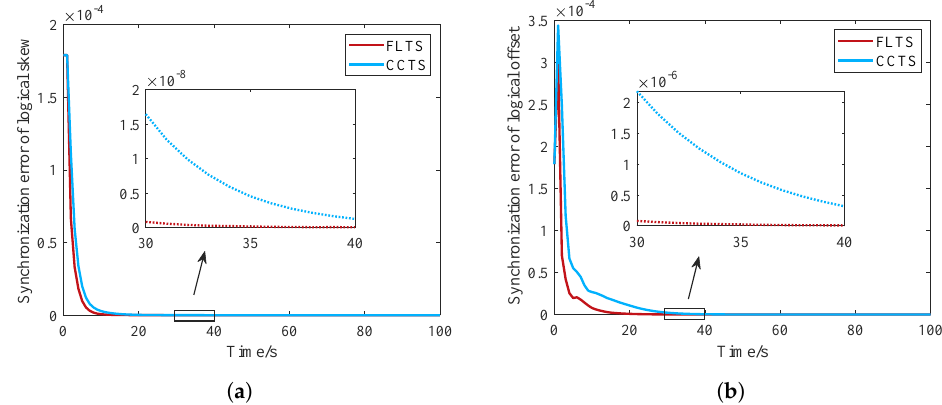
Figure 6. Convergence comparison of the logical clock in inter-cluster synchronization. ( a ) Logical clock skew; ( b ) Logical clock